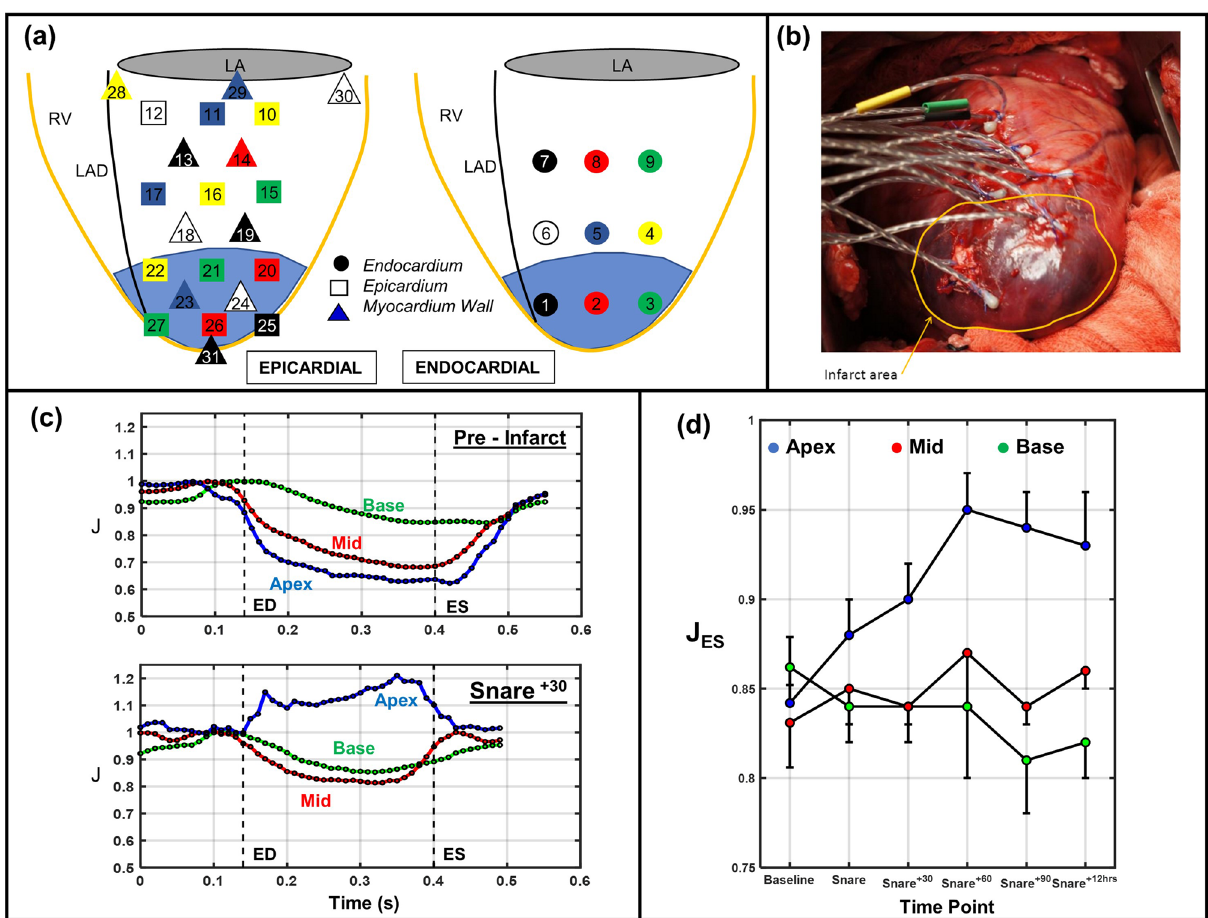
Figure 1. ( a ) Schematic showing sonocrystal array on endocardial and epicardial surfaces, ( b ) in-vivo sonocrystal deployment, ( c ) temporal changes of myocardial volume for apical, middle, and basal regions in one cardiac cycle: (top) pre-infarct, (bottom) 30 min post-infarct, ( d ) time evolution of volumetric change for apical, middle, and basal regions in both pre-MI and post-MI